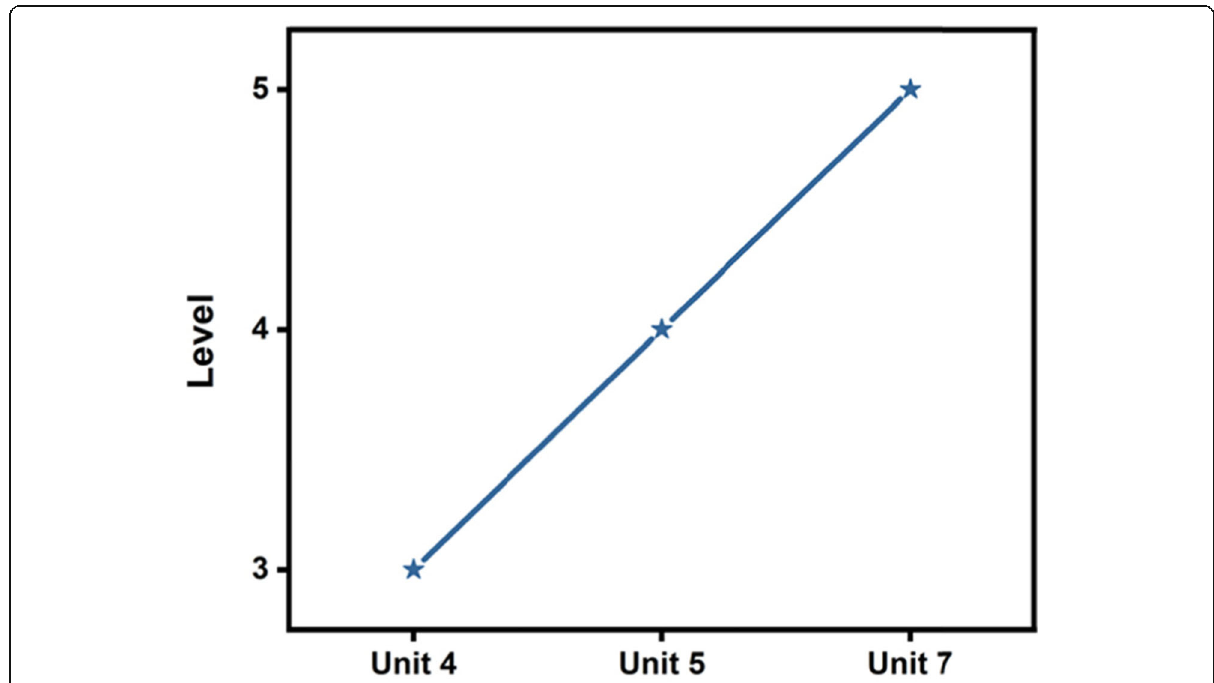
Fig. 6 The change trend of “ collaboration